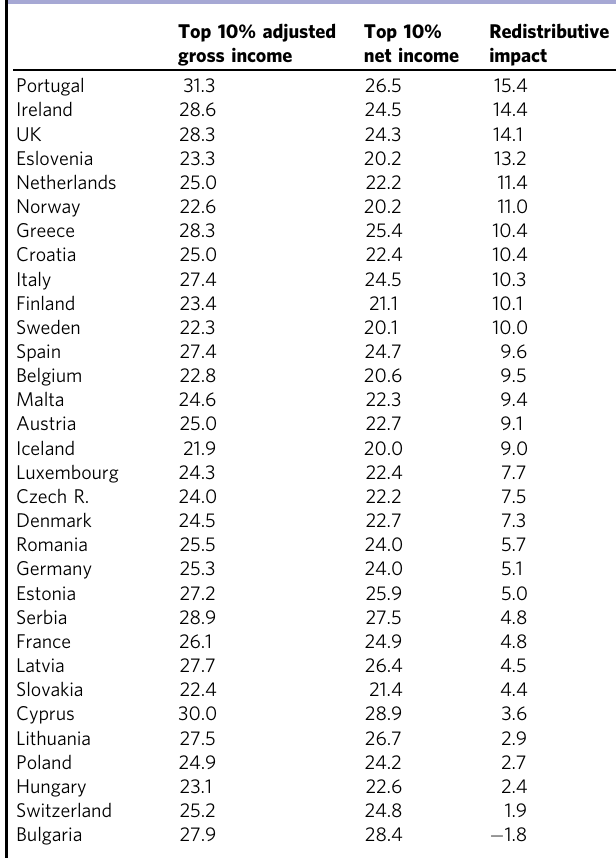
Table 2 Top 10% share of adjusted gross and net income, European countries (2013 – 2014)